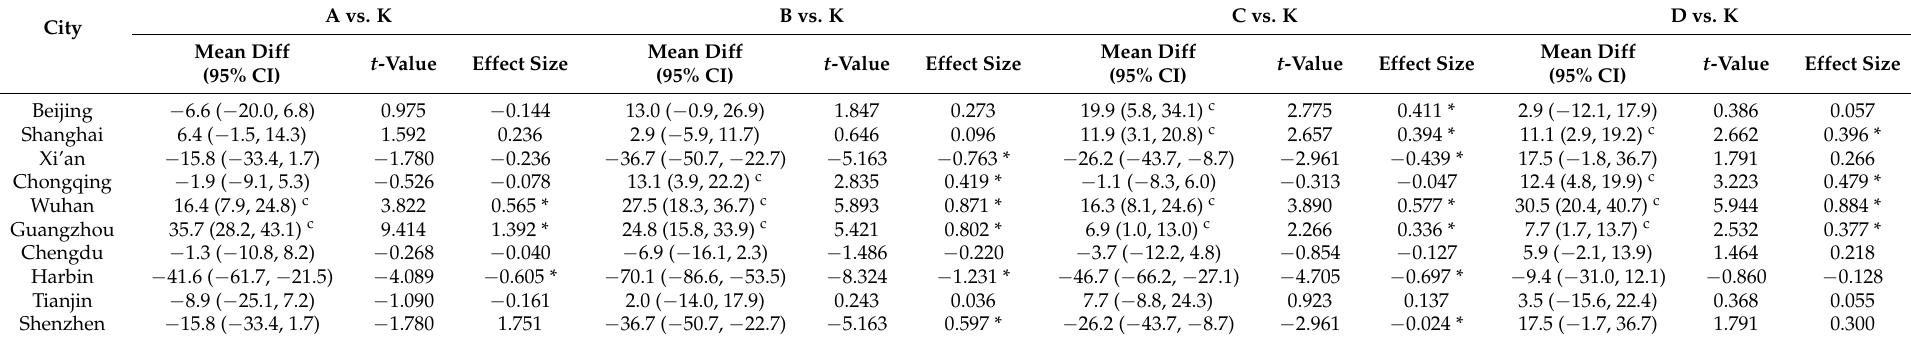
Table 4. Independent t -test comparing the means of AQI ( µ g m − 3 ) during and before the COVID-19